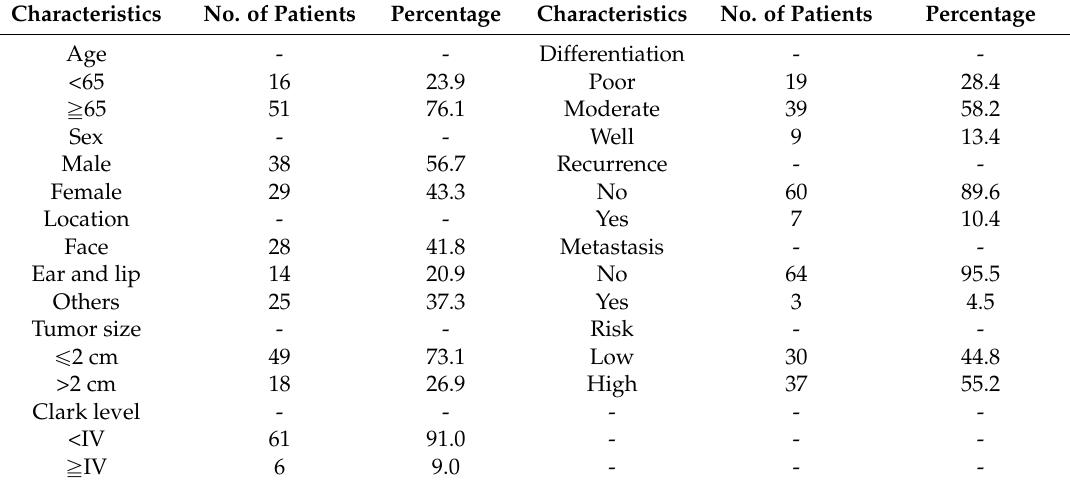
Table 1. Demographic and histopathological data of cutaneous squamous cell carcinoma patients. Characteristics No. of Patients Percentage